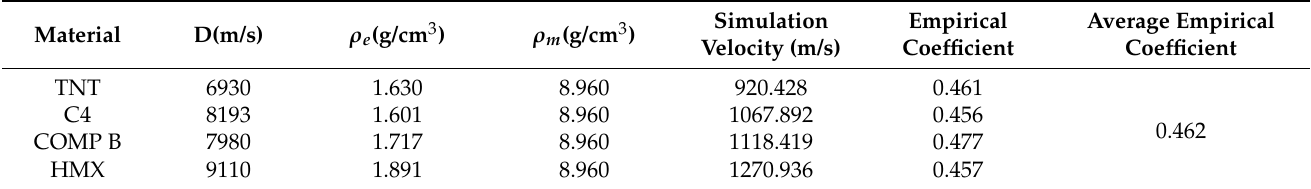
Table 7. Empirical coefficient of the head velocity of projectiles with different types of charge materials in